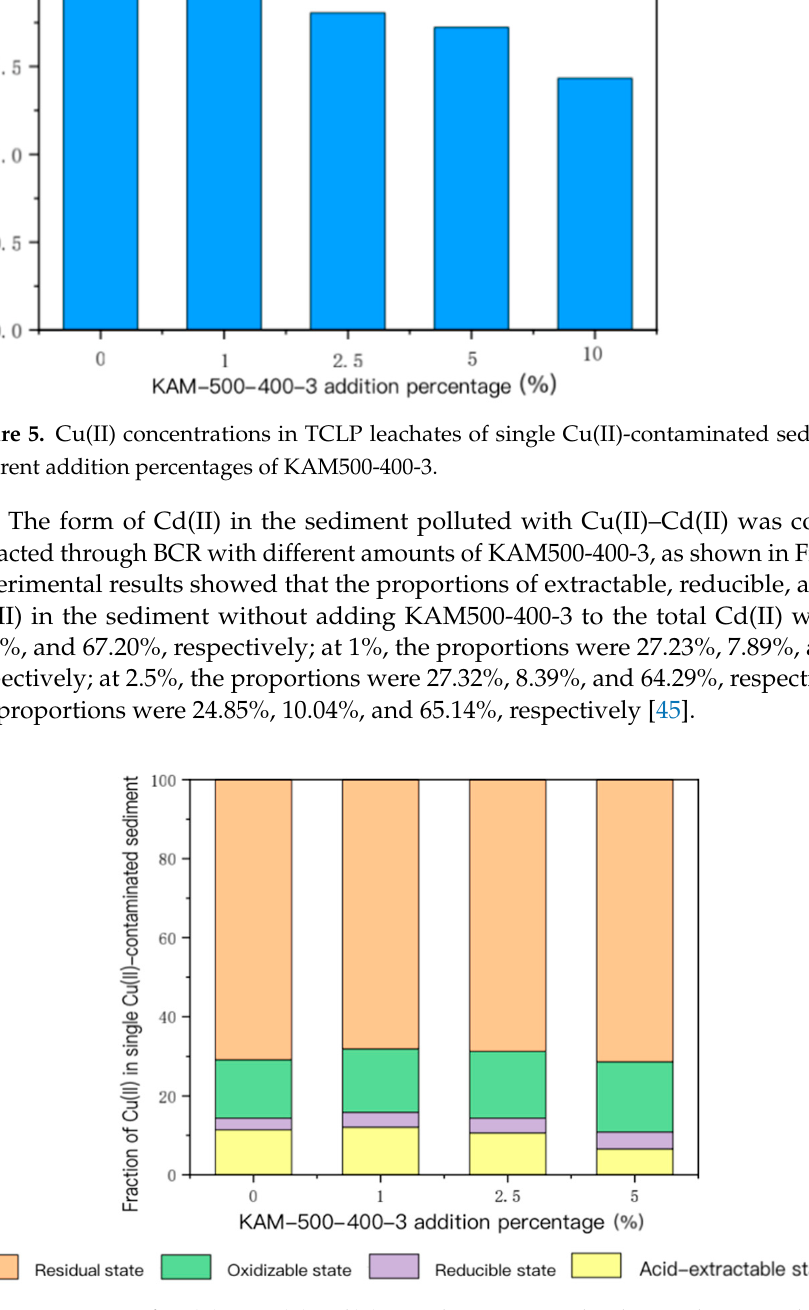
Figure 6. Fraction of Cu(II) in Cu(II)–Cd(II) mixed contaminated sediment determined through BCR sequential extraction under different addition percentages of KAM500-400-3.